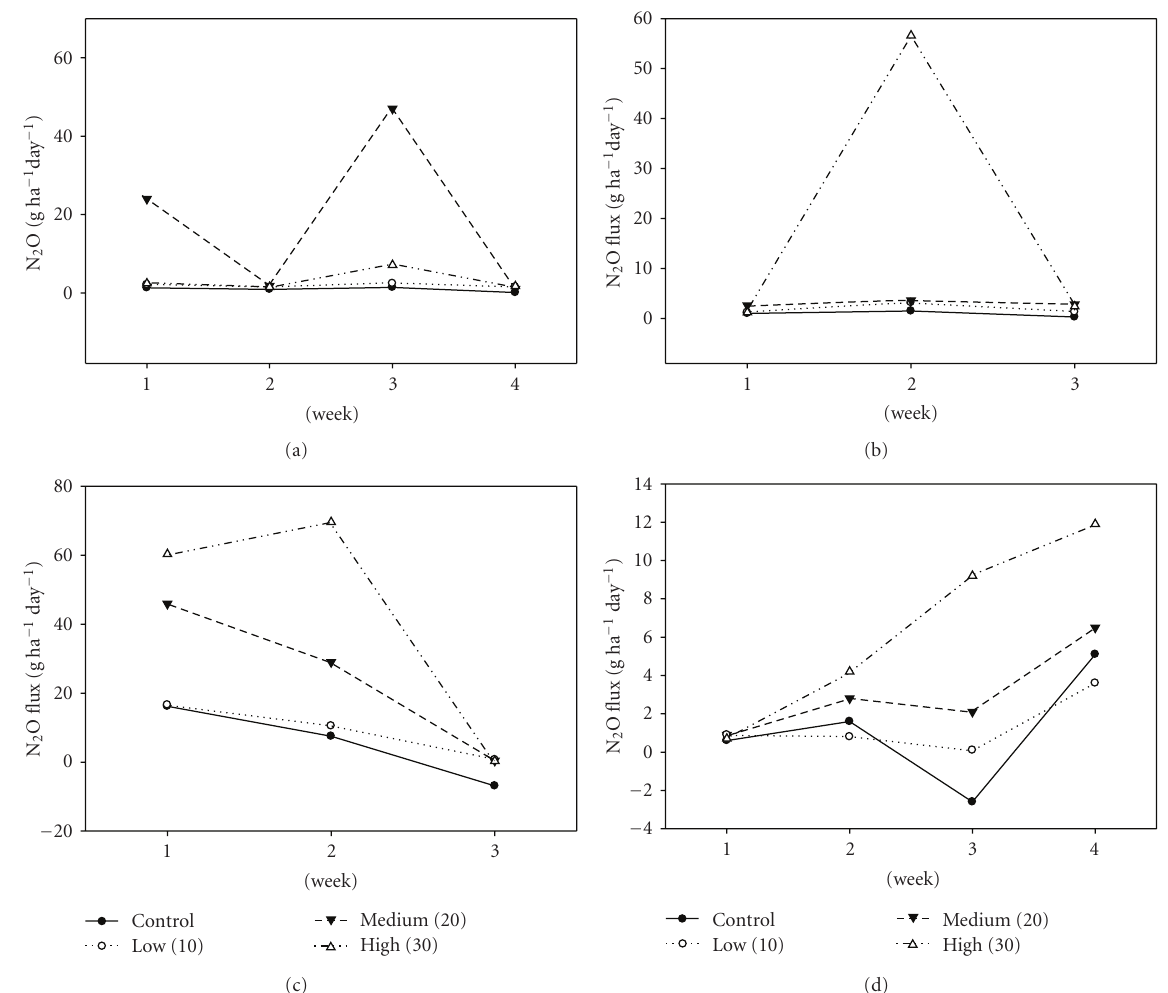
Figure 2: N 2 O flux over the entire course of the experiment according to the control, low, medium, and high earthworm density at (a) 15% ( P = . 1398), (b) 25% ( P = . 3912), (c) 35% ( P = . 2451), and (d) 45% ( P = . 0685) gravimetric soil water